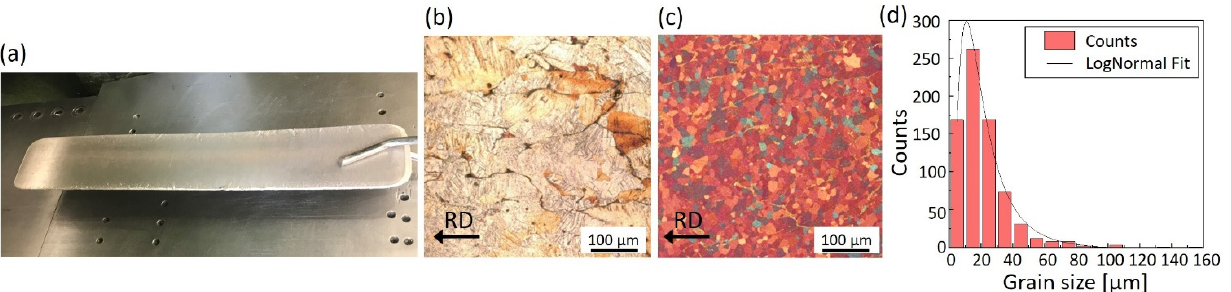
Figure 1. ( a ) LX41 rolled sheet with 65% thickness reduction, ( b ) optical micrograph of the rolling microstructure, ( c ) optical micrograph of microstructure after annealing at 350 °C for 30 min, ( d ) grain size distribution of an as-rolled sample after annealing.